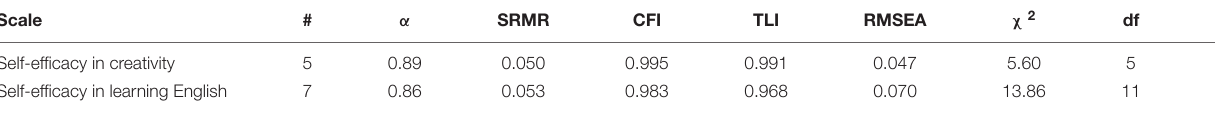
TABLE 1 | Goodness of fit in confirmatory factor analyses.